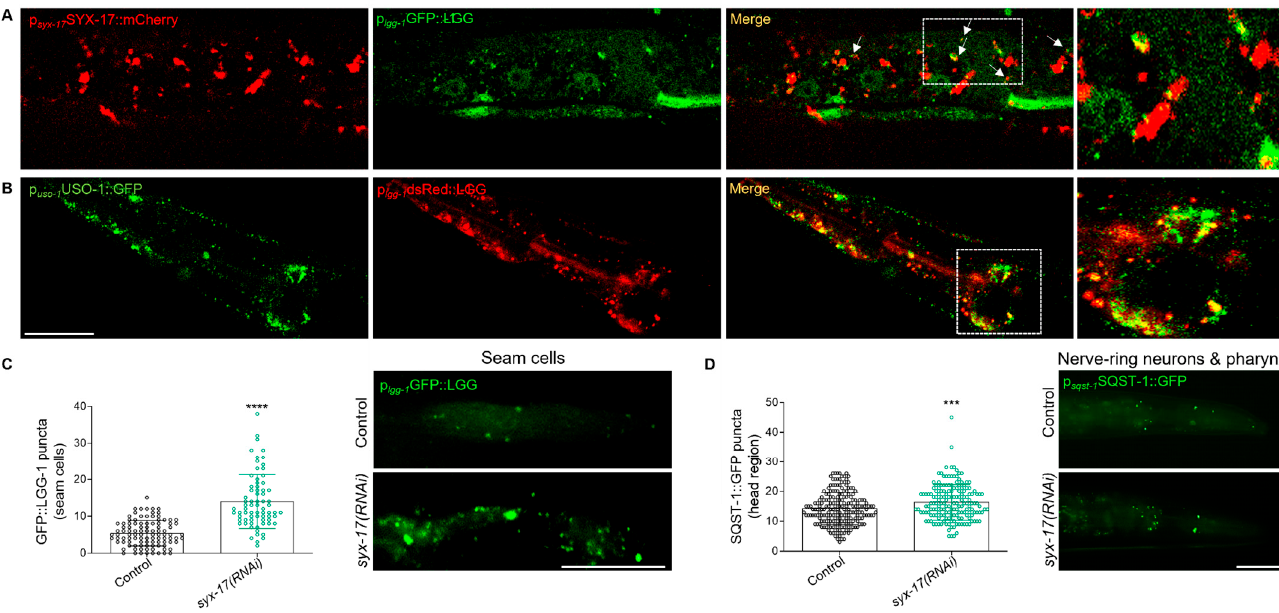
Figure 3. SYX-17 is required for basal autophagy. ( A ) SYX-17 fused with mCherry co-localizes with the autophagosomal protein LGG-1 markedwith GFP (63x lens, scale bar: 80 μ m) (MOC = 0.9160 ± 0.01347, M1 (SYX-17) = 0.3481 ± 0.07799, M2(LGG-1) = 0,1283 ± 0,04317). ( B ) USO-1 fused with GFP co- localizes with autophagosomal protein LGG-1 (63x lens, scale bar: 50 μ m) (MOC = 0.9358 ± 0.007102, M1 (LGG-1) = 0.4468 ± 0.1296, M2(USO-1) = 0.2256 ± 0.05246). ( C ) Quantification of LGG-1::GFP positive puncta in the seam cells of adult day 1 animals fed with the depicted dsRNA expressing bacteria (left panel) ( n = 172, **** p < 0.0001, unpaired two-tailed t -test) and representative epifluorescence images (right panel) (40x lens, scale bar: 25 μ m). The experiments were performed in 2 biological independent replicates with similar results. ( D ) Quantification of SQST-1::GFP positive puncta in the head region of adult day 1 animals fed with the depicted dsRNA expressing bacteria (left panel) ( n = 364, *** p = 0.0005, unpaired two-tailed t -test) and representative epifluorescence images (right panel) (40x lens, scale bar: 50 µ m). The experiments were performed in 2 biological independent replicates with similar